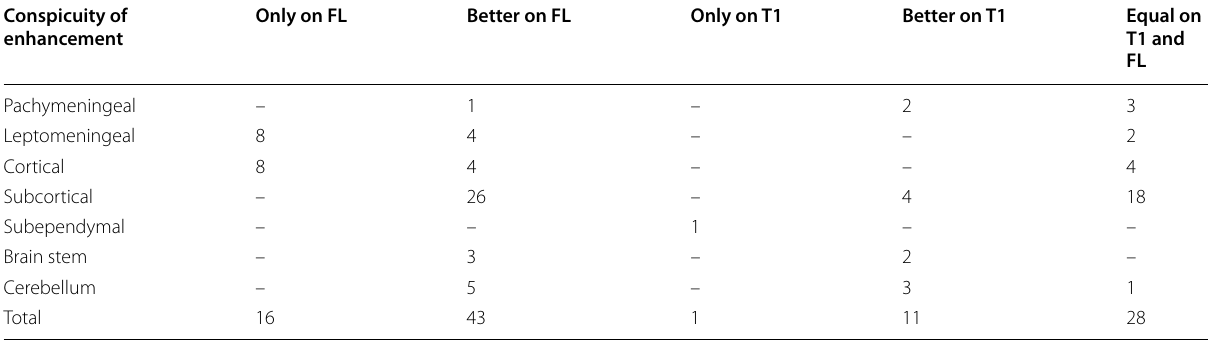
Table 2 Summary of the enactment conspicuity detected by CE-T1WI and delayed post-contrast FLAIR in the different supra and infratentorial